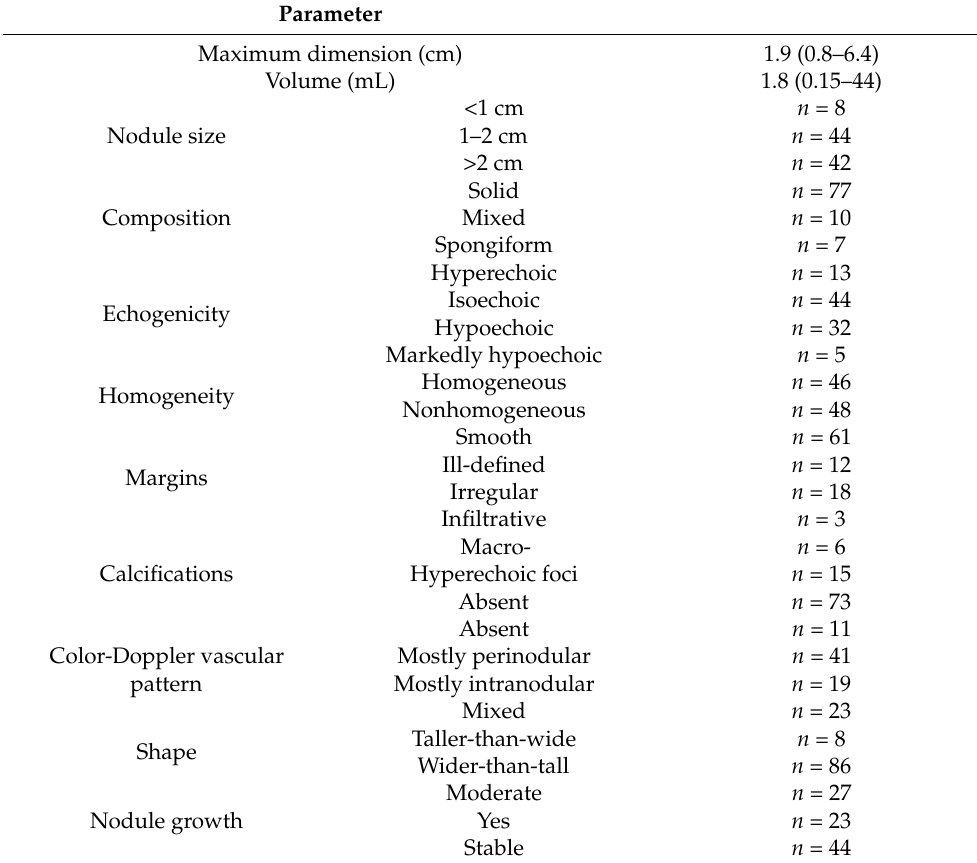
Table 3. Ultrasound characteristics of the analyzed thyroid